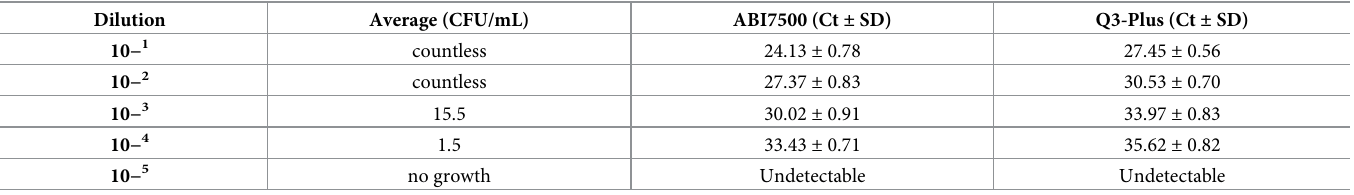
Table 5. Colony forming unit and IS 6110 detection by two qPCR instruments using 1:10 dilutions of a M . tuberculosis cell suspension.